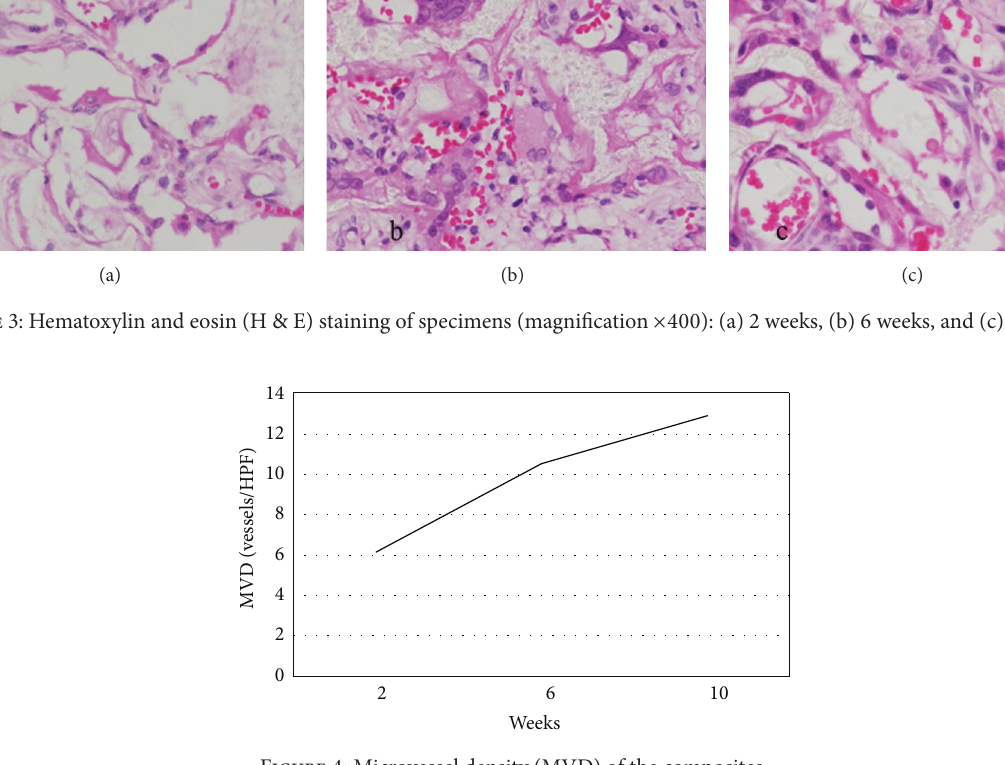
Figure 4: Microvessel density (MVD) of the composites.